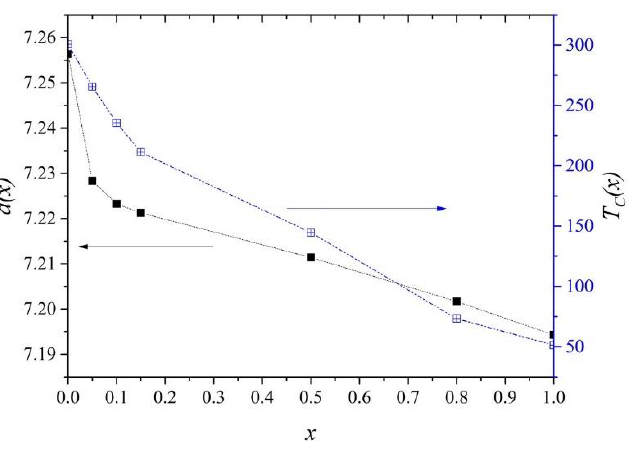
Figure 1. Lattice parameter a as a function of x (left axis). Curie temperature T C derived from magnetic measurements, discussed in Section 2.2 (right axis).